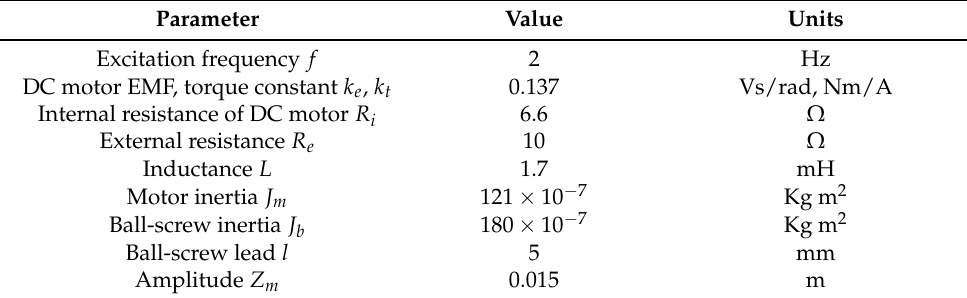
Table 1. Parameters for the ball-screw damper.